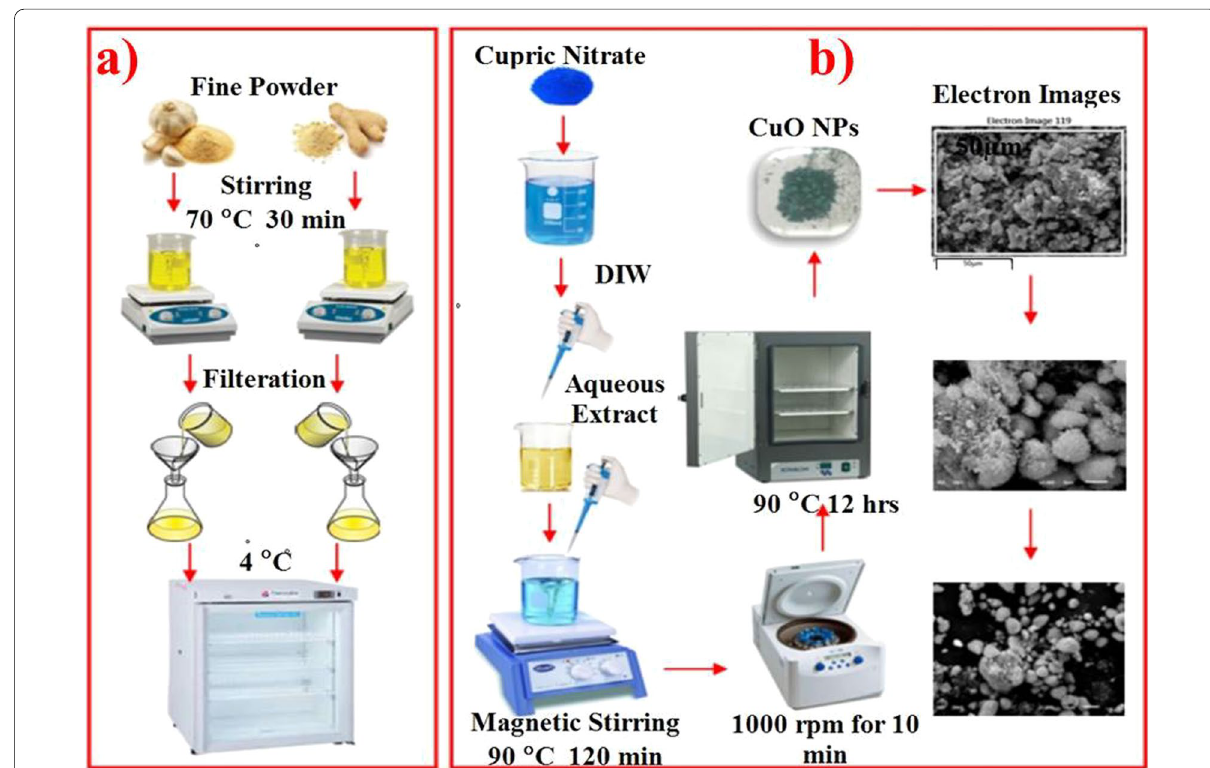
Fig. 1 Overview of a aqueous extraction of Zingiber officinale and Allium sativum roots, b green synthesis of CuO